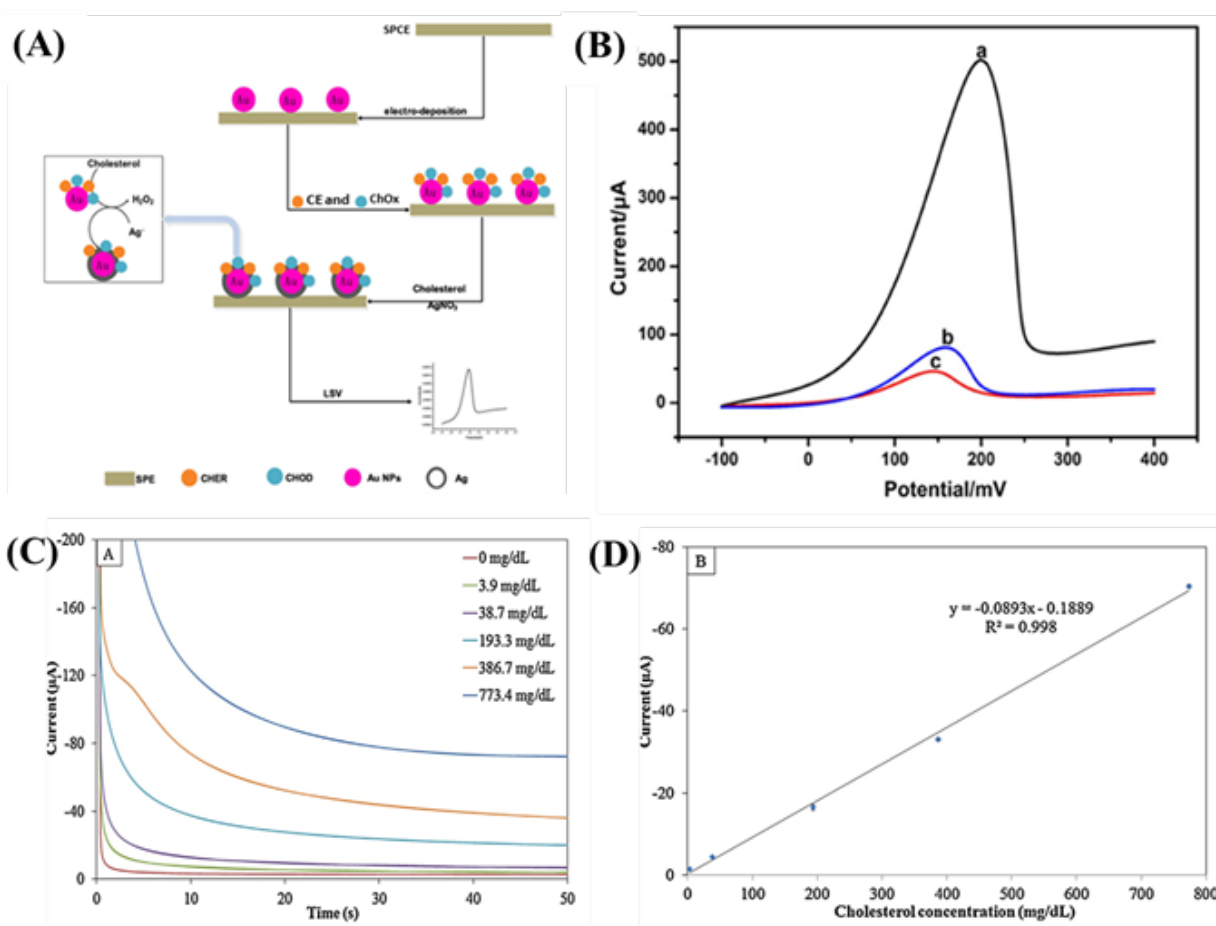
Figure 3. ( A ) Schematic for the principle of the developed biosensor for cholesterol detection, ( B ) LSV curves of the Ag/CE&ChOx/Au NPs/SPCE in the presence of cholesterol (a), the Ag/CE&ChOx/Au NPs/SPCE without the presence of cholesterol (b), and the Ag/Au NPs/SPCE in the presence of cholesterol (c). The concentration of cholesterol was 5.0 mg mL − 1 and the current signal was obtained by the LSV which was carried out in 0.1 mol/L HNO 3 solution containing 0.6 mol/L of KNO 3 from − 0.1 to 0.6 V with a 100 mV/s scanning rate [35]. Reprinted with permission from ref. [35]. Copyright 2017 Elsevier ( C ) Chronoamperograms of 0–773.4 mg/dL of cholesterol determination at − 0.5 V versus Ag/AgCl. ( D ) The calibration graph of cholesterol over the concentration range of 3.9 to 773.4 mg/dL [37]. Reprinted with permission from ref. [37]. Copyright 2015 Elsevier.